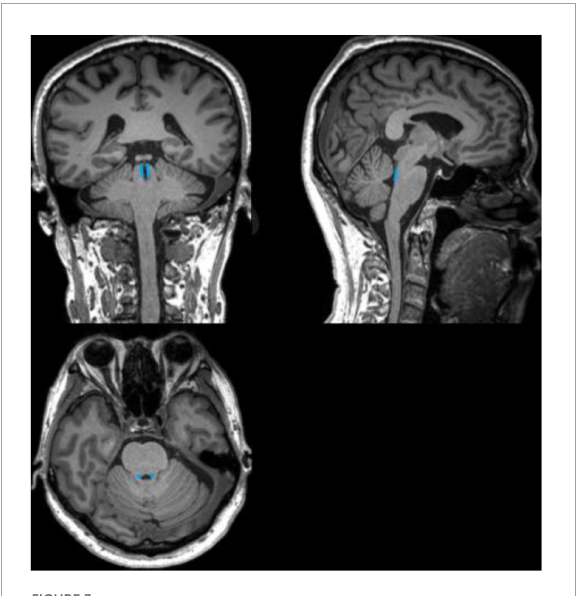
FIGURE3 Schematic diagram of the anatomical location of the locus coeruleus (LC). The schematic diagram shows coronal, sagittal, and axial 3D-T1WI images from a 71-year-old healthy control, with the anatomical location of the LC outlined in